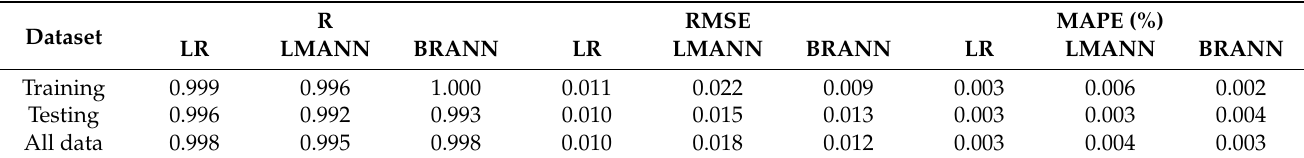
Table 8. Selected performance values of the applied